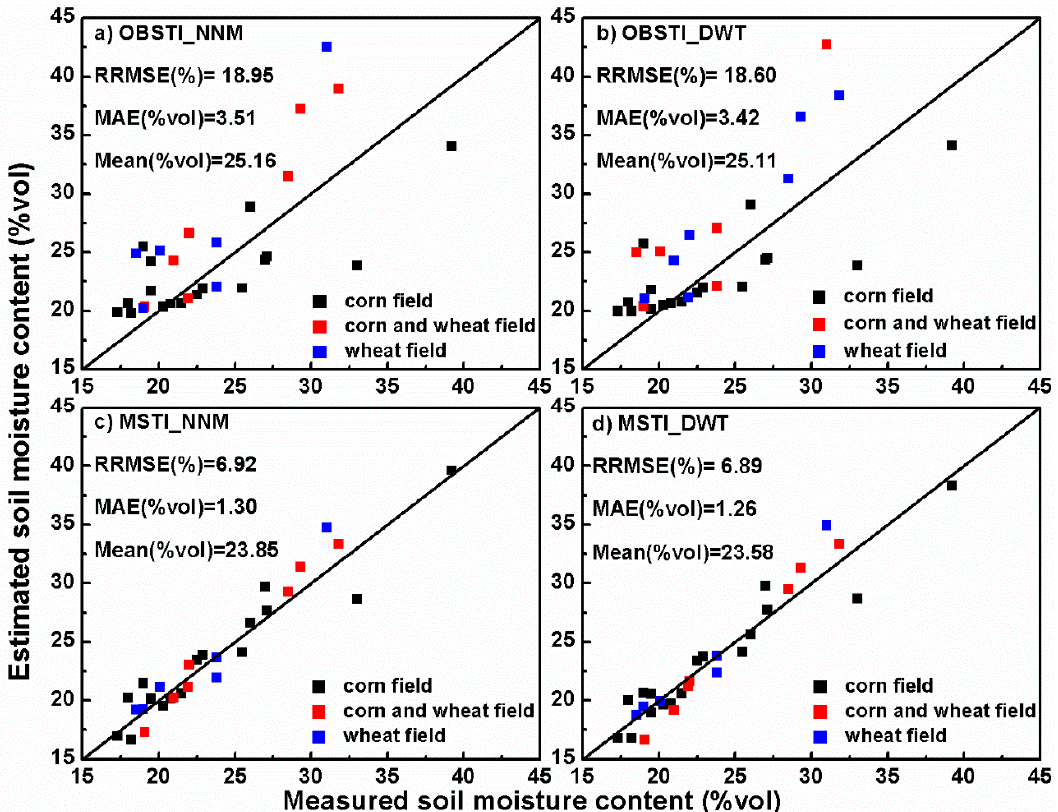
Figure 15. The field measurements of soil moisture content (SMC) versus the estimates: ( a ) Figure15. Thefieldmeasurementsofsoilmoisturecontent(SMC)versustheestimates: ( a )OBSTI_NNM: OBSTI_NNM: the original-model-based bare STI using 15 m resolution thermal infrared bands the original-model-based bare STI using 15 m resolution thermal infrared bands by re-sampling using by re-sampling using the nearest neighbor method; ( b ) OBSTI_DWT: the original-model-based the nearest neighbor method; ( b ) OBSTI_DWT: the original-model-based bare STI using 15 m resolution bare STI using 15 m resolution fusion thermal infrared bands; ( c ) MSTI_NNM: the modified- fusion thermal infrared bands; ( c ) MSTI_NNM: the modified-model-based STI using 15 m resolution model-based STI using 15 m resolution thermal infrared bands by re-sampling using the thermal infrared bands by re-sampling using the nearest neighbor method; ( d ) MSTI_DWT: the modified nearest neighbor method; ( d ) MSTI_DWT: the modified model based thermal inertia using 15 model based thermal inertia using 15 m resolution fusion thermal infrared m resolution fusion thermal infrared bands.